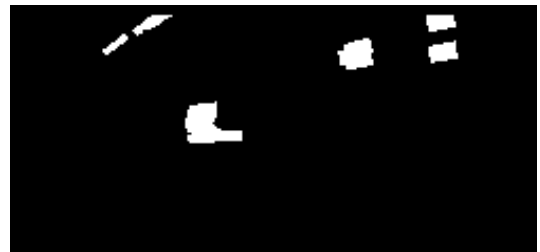
Figure 5. The measurement binary obstacle grid.